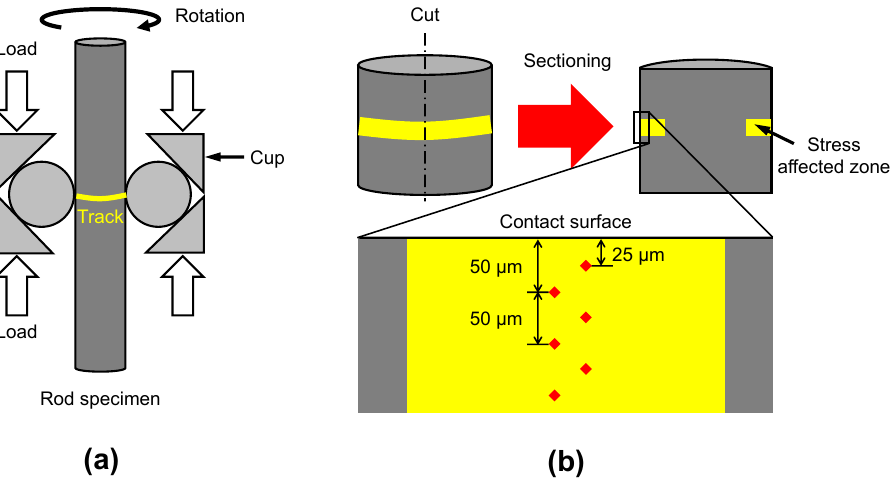
Figure 1. Experimental methods: ( a ) schematic of rolling contact fatigue testing; ( b ) specimen sectioning and hardness measurement.